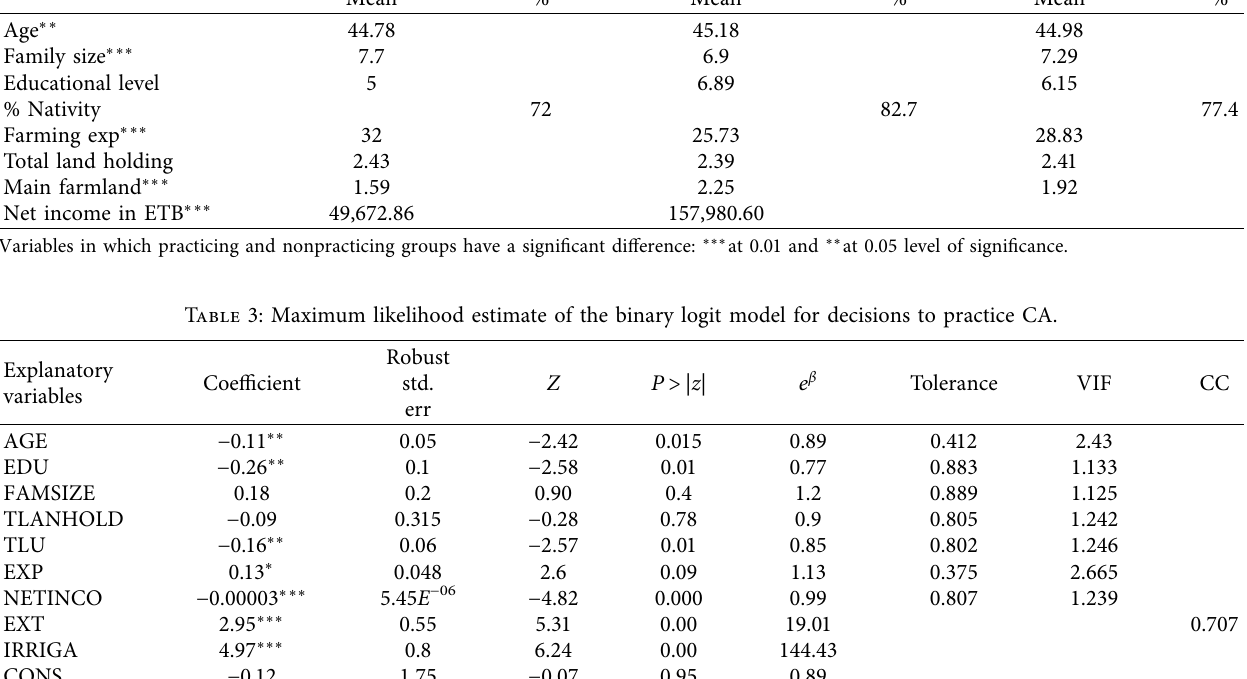
Table 2: Descriptive statistics of CA and CT practitioners in Derashe and Arba Minch Zuriya districts. Variables